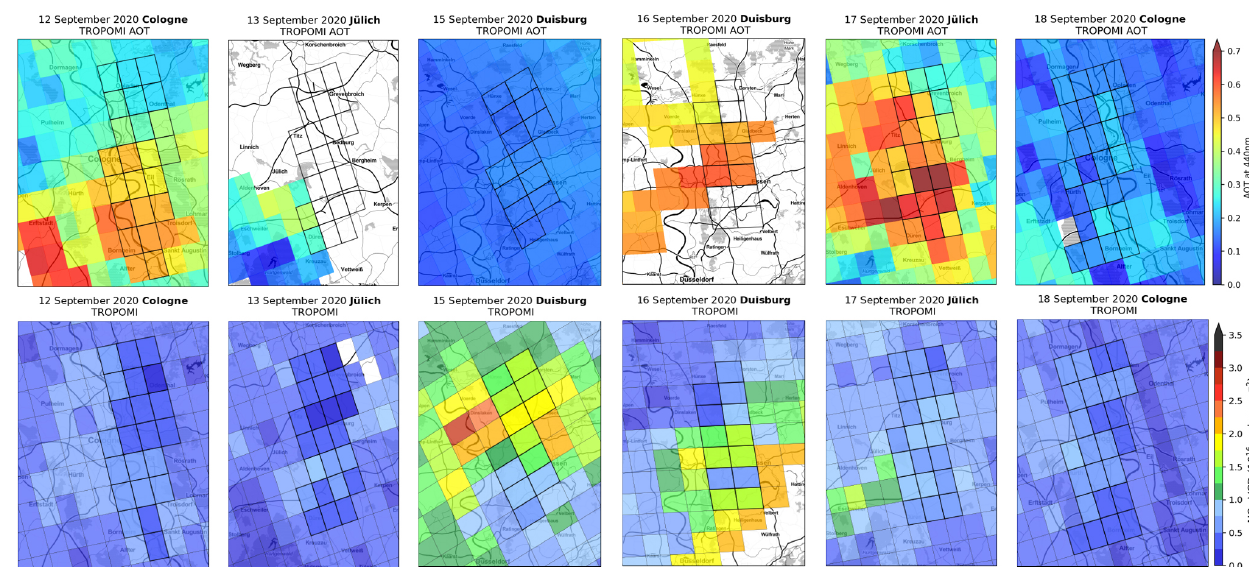
Figure A4. Daily maps of (top) TROPOMI AOT at 440nm where the qa_value is > 0.5 and (bottom) TROPOMI PAL V02.03.01 tropospheric NO 2 VCDs where the qa_value is > 0.75. Black boxes represent TROPOMI pixel outlines that fulfill the co-location criteria of having an